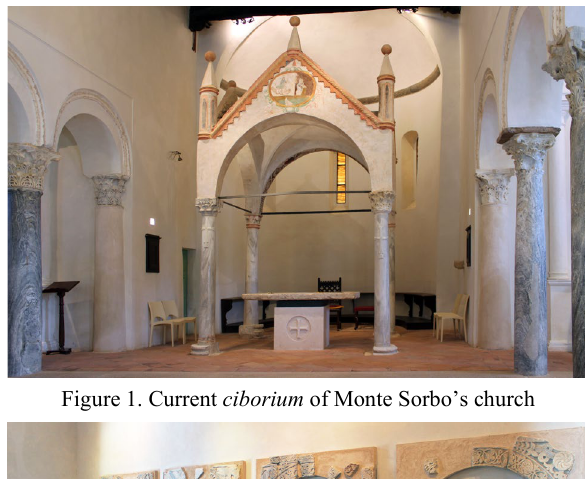
Figure 1. Current ciborium of Monte Sorbo’s church